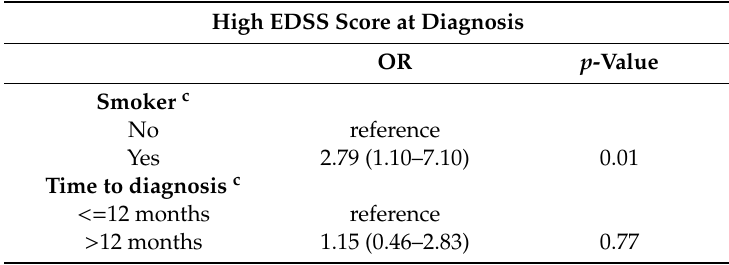
Table 4. Association between various patient characteristics and high EDSS score at diagnosis ( >